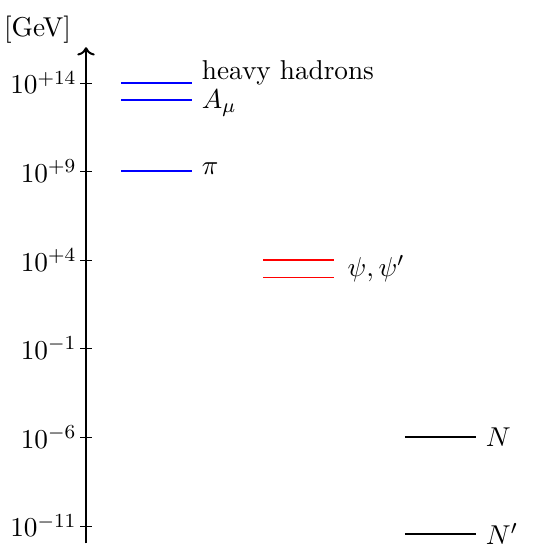
Figure 1 . Schematic representation of the mass scales involved. See the text for